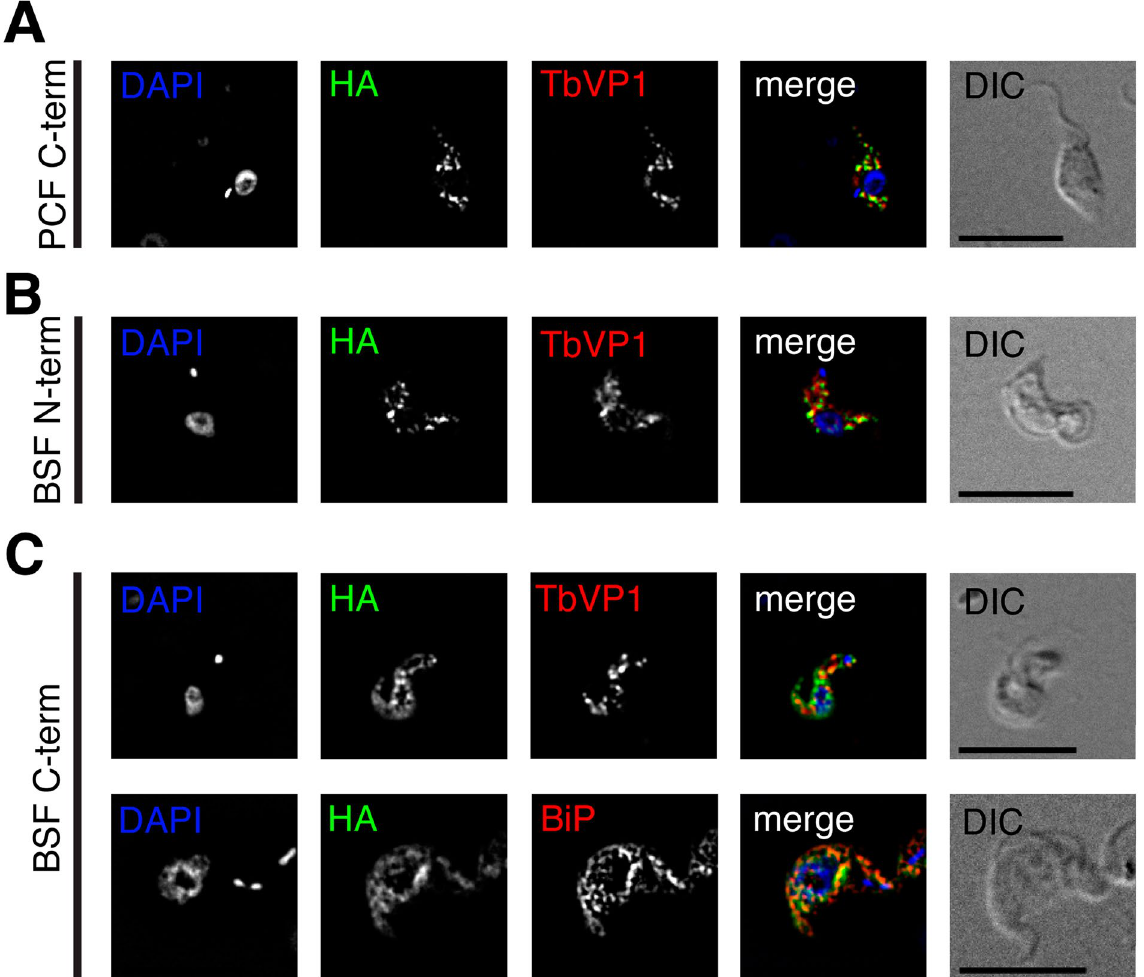
Figure 5. TbIRK co-localizes with a marker for acidocalcisomes. Co-localization of hemagglutinin (HA)- tagged TbIRK (green) with the acidocalcisomal marker TbVP1 (red) for C-terminally tagged TbIRK in procyclic form parasites (PCF, A ) and N-terminally tagged TbIRK in bloodstream form parasites (BSF, B ). ( C ) With the HA-tag at the C-terminus of TbIRK, its signal (green) partially co-localizes with TbVP1 (red, top) and partially with the ER marker BiP (red, bottom). Cells were counterstained with DAPI, shown in blue, visualizing the nuclear and kinetoplast DNA. DIC, differential interference contrast. Scale bars indicate 10 µ